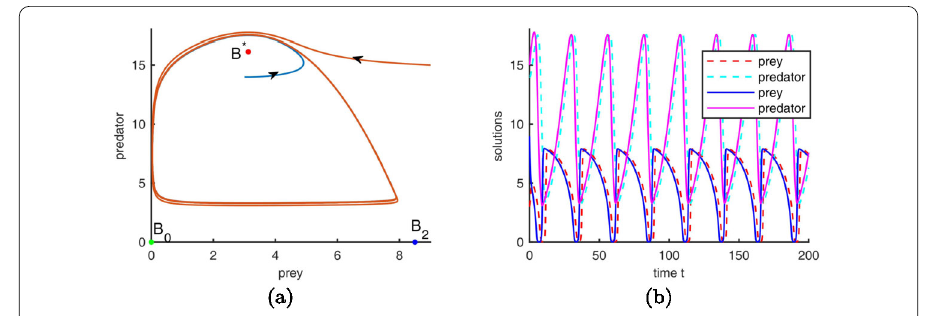
Figure 11 ( a ) The phase diagram of model (1.3) for r = 6, a = 0, f = 0; ( b ) solution curves for r = 6, a = 0, f = 0. The initial values are (3,14),